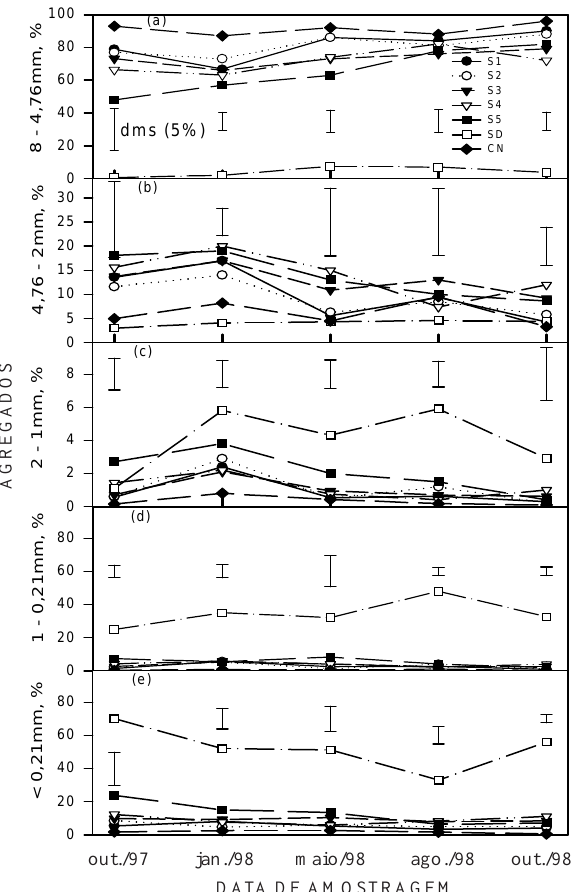
Figura 2. Percentagem de agregados por classe de tamanho pelo método-padrão em diferentes épocas do ano, para os tratamentos S1 (soja/ azevém + ervilhaca/milho), S2 (soja/nabo forrageiro/milho), S3 (feijão preto + mucuna/ resíduos de mucuna/milho), S4 (feijão preto + feijão-de-porco/resíduos de feijão-de-porco/ milho), S5 (soja/pousio invernal/milho), SD (solo descoberto), CN (campo natural). A barra vertical corresponde à diferença mínima significativa (DMS) a 5